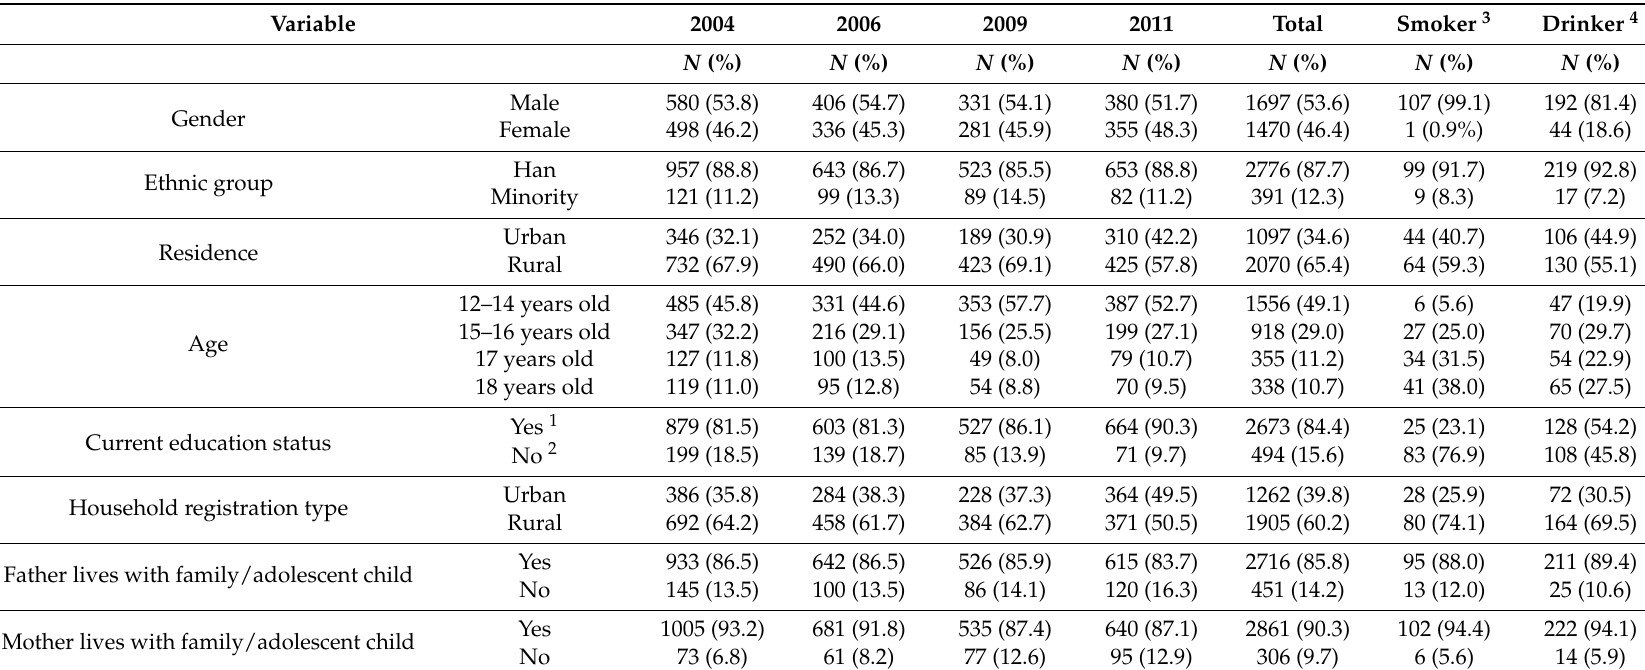
Table 1. Characteristics of 3176 study participants stratified by survey year (N, %),